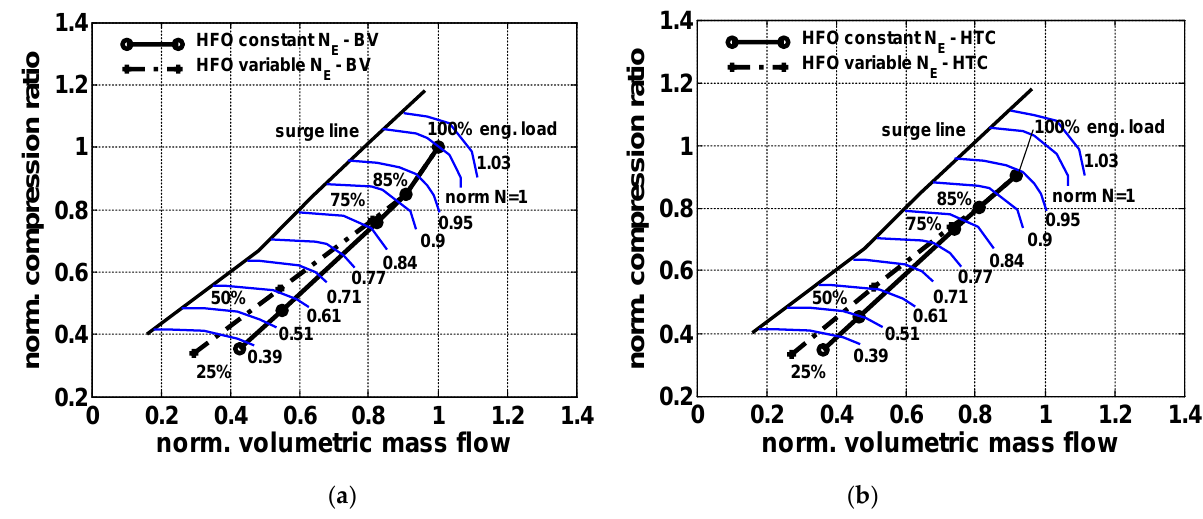
Figure 7. Working points in the compressor map for the HFO-powered engine, with original TC (a) and HTC (b) , at constant and variable engine speeds N E .